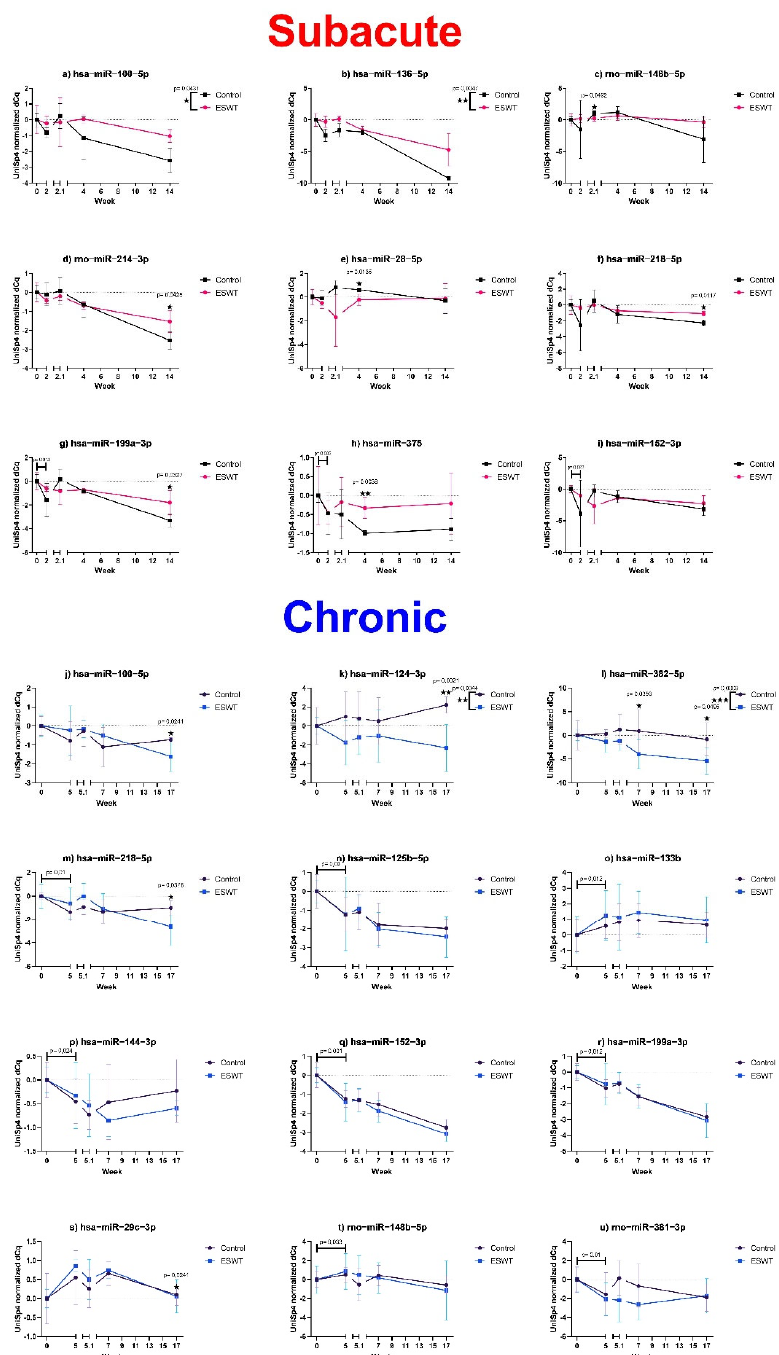
Figure 7. Longitudinal miRNA expression profile. Figure 7 shows the mean and standard deviation of baseline normalized miRNA serum levels of control (black) and chronic ( a : blue), as well as subacute ( b : red) treatment groups plotted against time. Note that the x-axis is stretched between the timepoints of the first treatment and 1 h after the first treatment (labeled as timepoints 2.1 and 5.1 for subacute and chronic experimental settings, respectively) for improved visualization of acute treatment effects. Significant differences in weekly mean (RM 2-way ANOVA) are indicated by an asterisk, and significant overall treatment effects are indicated by an asterisk and the p -value at the top right of the corresponding graph (values with p < 0.05 are summarized as a single asterisk “ (cid:70) ”, p < 0.01 as ” (cid:70)(cid:70) ”, p < 0.001 as ” (cid:70)(cid:70)(cid:70) ”). Diagnostic markers (pre-OP versus first observational timepoint) are marked by a line with the respective p